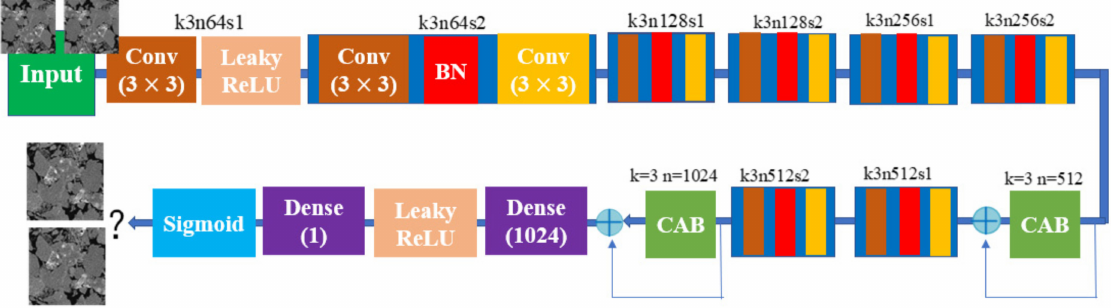
Figure 7. Architecture of